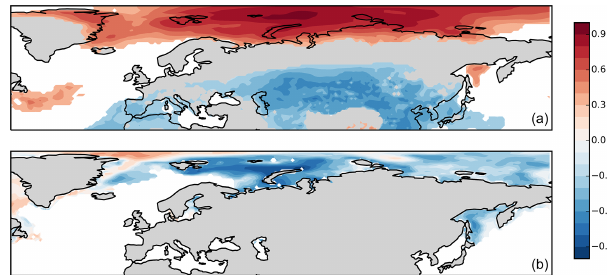
Figure 4. Spatial distribution of the first SVD mode calculated over the Northern Hemisphere, mapped as homogenous correlation with surface air temperature (a) and sea-ice concentration (b) from ERA5, for the period of 1998 to 2012. Covariance explained is 59% and correlation coefficient is r = 0 . 84. Contour interval is